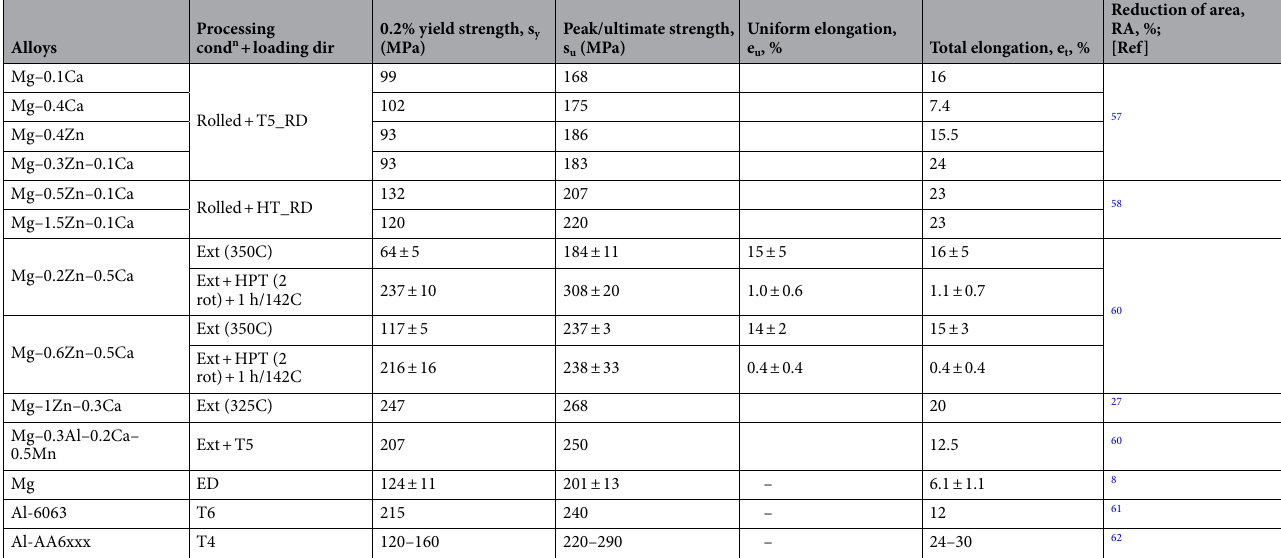
Table 2. Room temperature tensile properties of peak-aged and annealed BioMg250 compared to many other Mg alloys in the literature 3,8–16,26,27,42,47–58,60–62 .